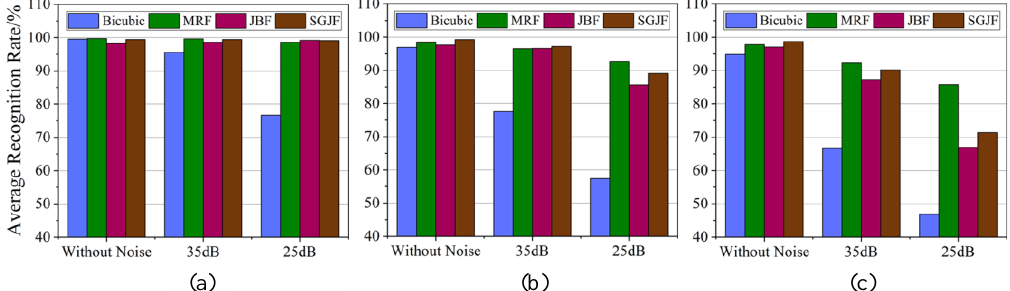
Figure 8. Comparison of the average recognition rates of different SR algorithms and factors with noise. ( a ) 𝑑 = 𝑠 = 2 . ( b ) 𝑑 = 𝑠 = 4 . ( c ) 𝑑 = 𝑠 = 8 .